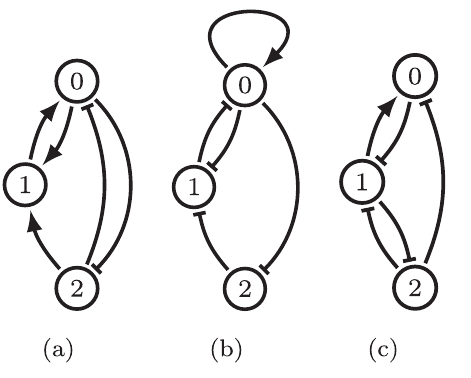
Fig 10. (a) Regulatory network 33. (b) Regulatory network 108. (d) Regulatory network